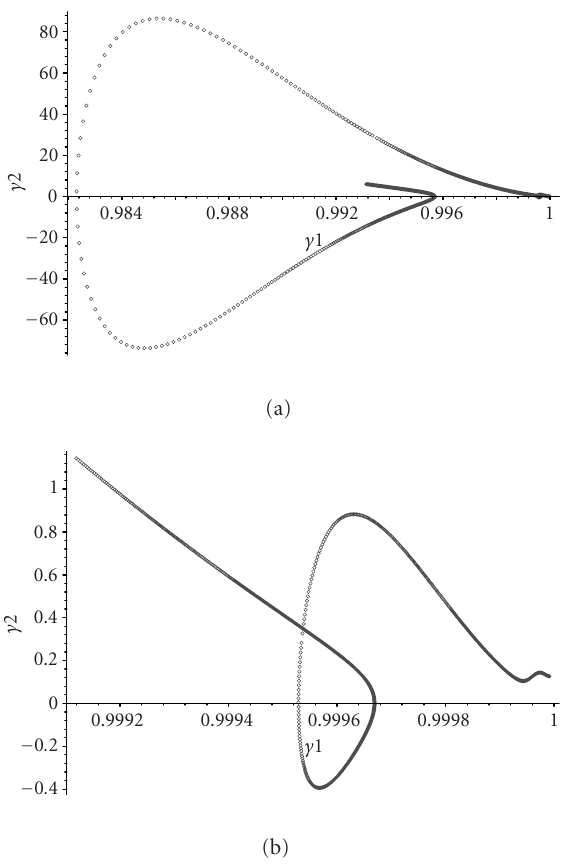
Figure 5.7. (a) ˙ ε , ε plane in the τ interval represented in Figure 5.3; (b) ˙ ε , ε plane in the τ interval represented in Figure 5.4, including the details corresponding to Figure